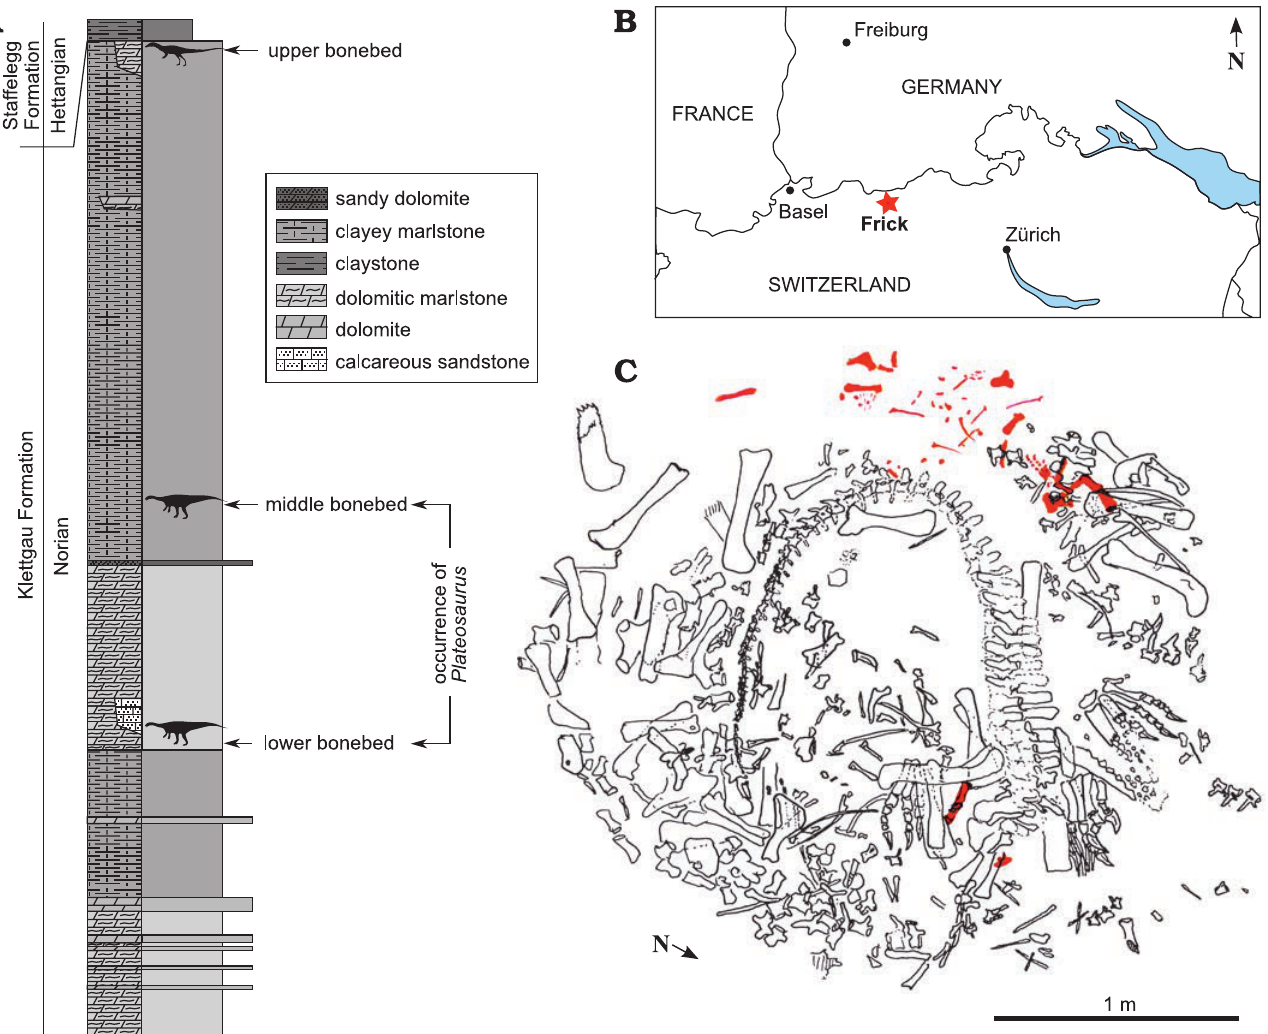
Fig. 1. A . Stratigraphic section of Gruhalde Member (Klettgau Formation) exposed at Gruhalde Quarry in Frick (redrawn from Jordan et al. 2016). B . Location of Frick in northern Switzerland (asterisk). C . Excavation map of bone concentration MSF 15.8., juvenile Plateosaurus cf. trossingensis skeleton MSF 15.8B. in red (after Ben Pabst, used with